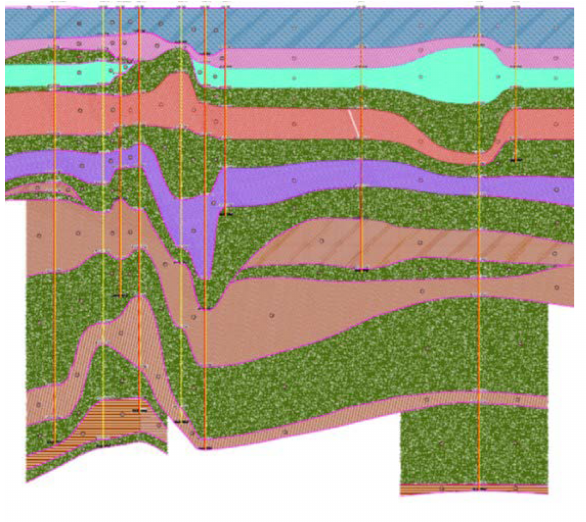
Figure 2. Local extract of geologic section over length of about 13km with deepest borehole to 302m. The reddish or brownish colours are for silty Clays, and the greenish colours are Sands (from VIGMR, 2017).